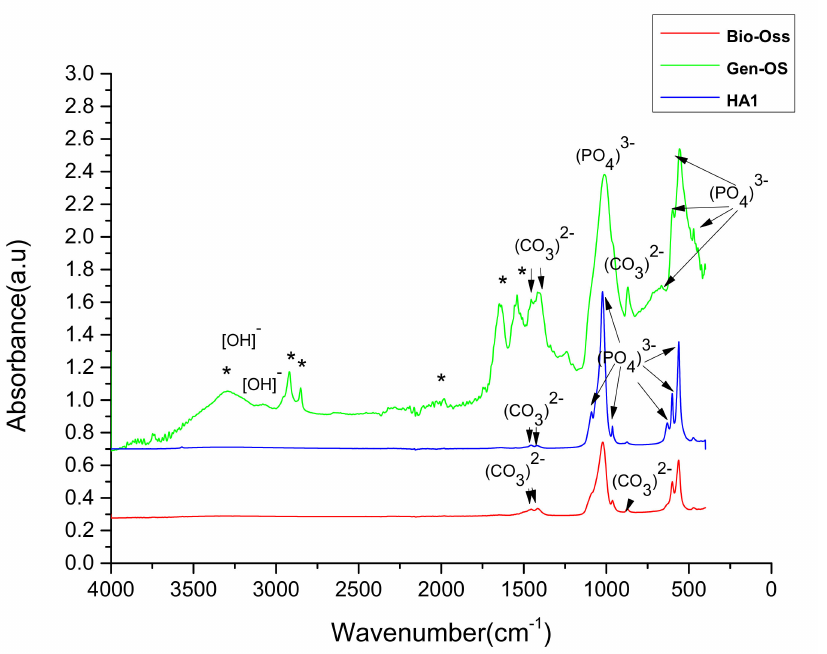
Figure 2. FTIR absorption spectra for xenograft Bio-Oss, Gen-Os, and HA1 powder: (*) absorption bands for protein functional